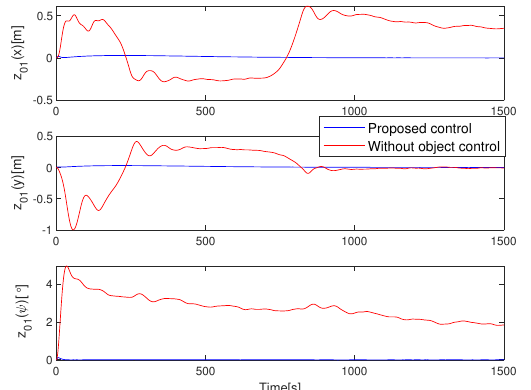
Figure 4. Tracking errors of the platform using two control methods.